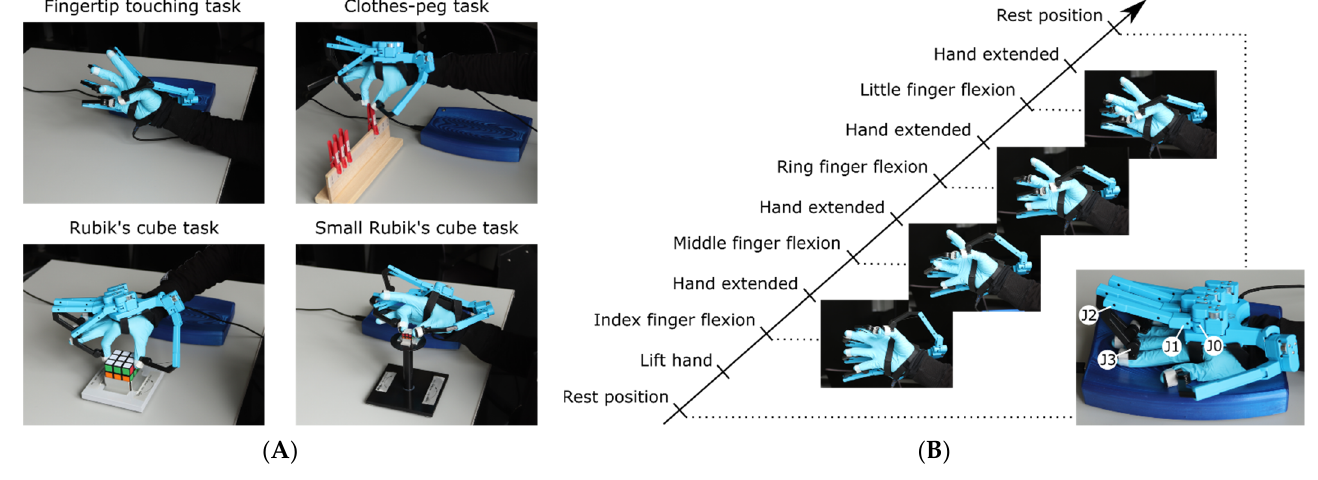
Figure 1. Movement tasks. ( A ) Four different tasks were performed requiring precision grips of the index, middle, ring and little fingers. Note that the Rubik’s cube and small Rubik’s cube tasks were performed twice, i.e., clockwise and counterclockwise (see also Supplementary Video S1). ( B ) One trial comprised a sequence of grips of each of these fingers performed self-paced (except the fingertip touching whose movements were triggered every 2 s by an acoustic signal). In the image showing the rest position, the exoskeleton data glove’s joints of the index finger are exemplarily annotated (abduction sensor J0 and finger flexion sensors J1–J3).